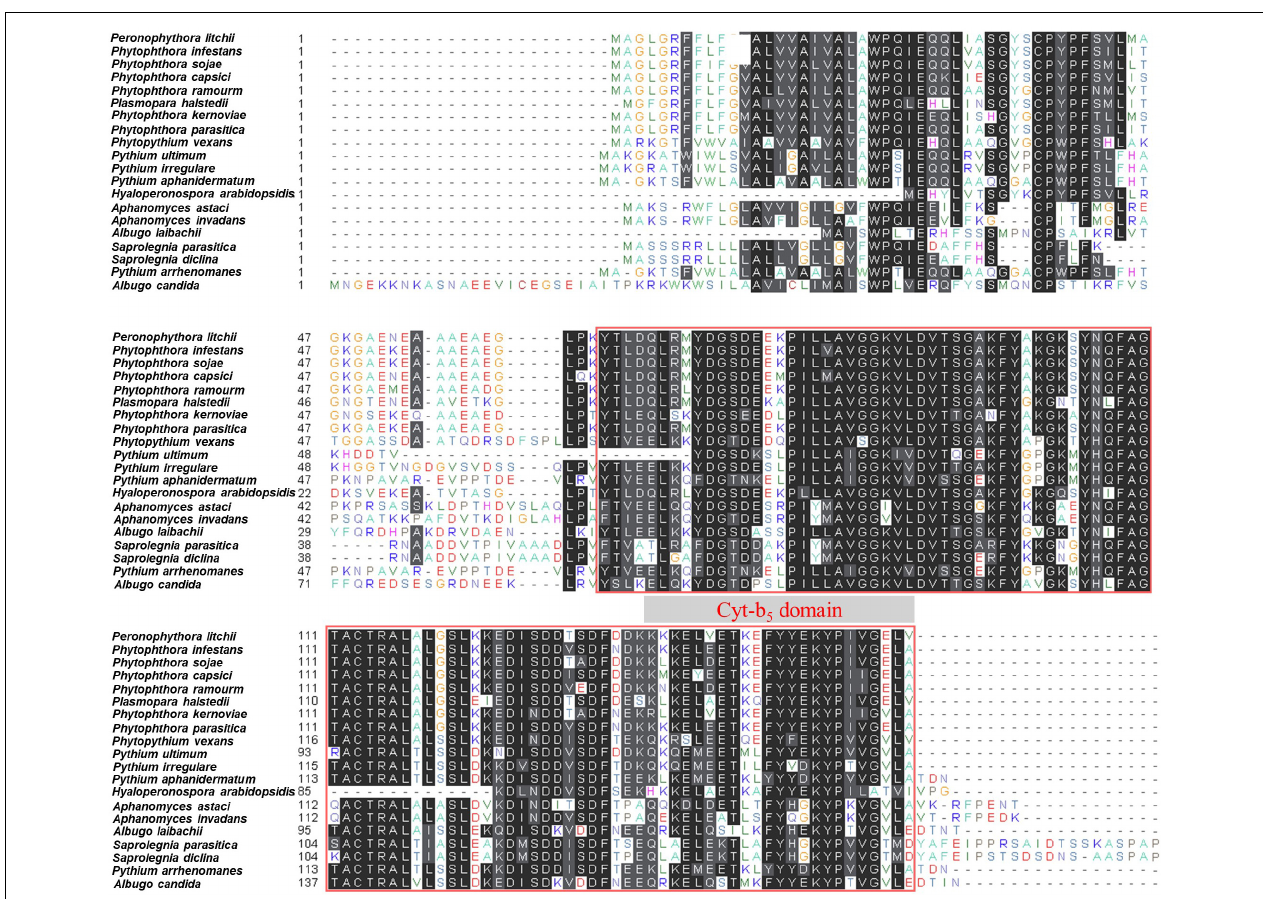
FIGURE 3 | Domain arrangement of PlCB5L1 protein and its orthologs. Protein sequence alignment of PlCB5L1 and its orthologs from 19 oomycete species. Columns with identical and similar amino acid sequences were colored black and gray, respectively. The red box indicates Cyt-b 5